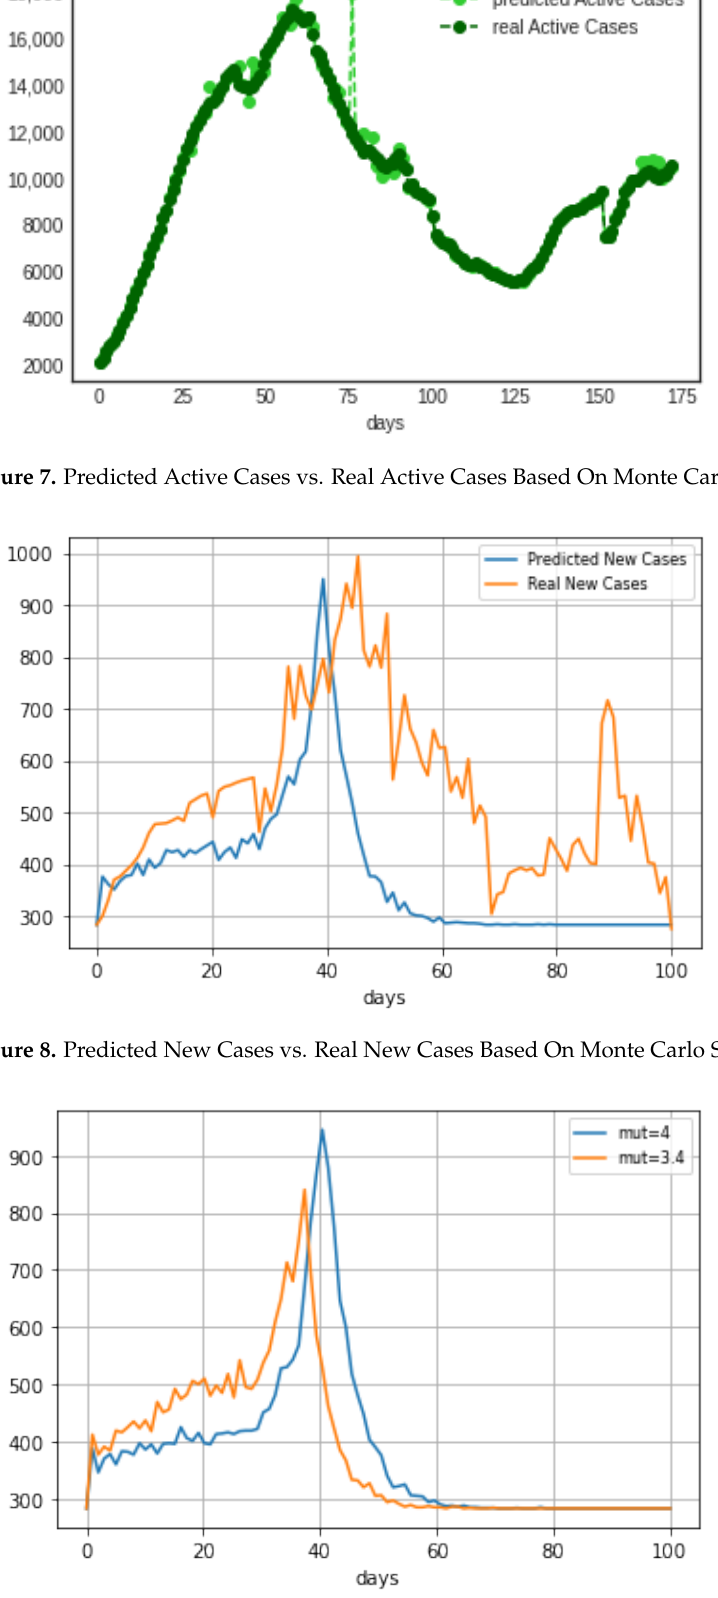
Figure 9. Predicted New Cases with different Infected days